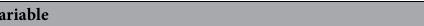
Table 4. Laboratory data of elderly patients with organophosphate poisoning (n = 71), stratified according to mortality status. Continuous variables were presented as the means and standard deviations. * P < 0.05, ** P < 0.01; pCO2 partial pressure of carbon dioxide; pO2; partial pressure of